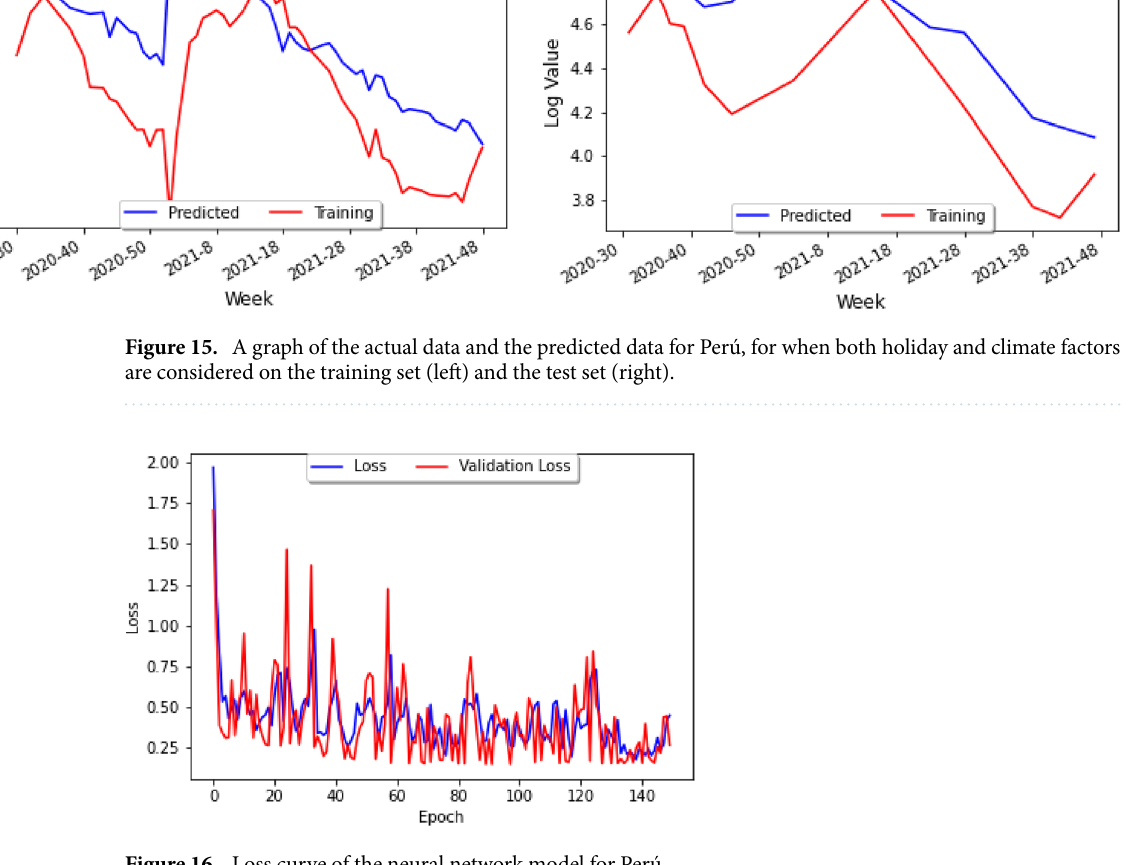
Figure 16. Loss curve of the neural network model for